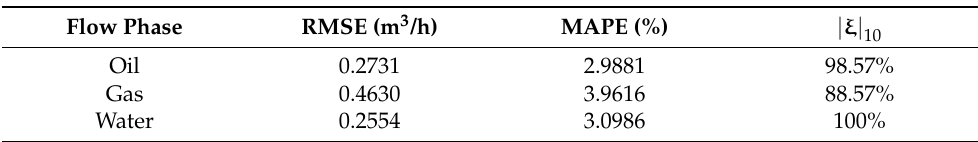
Table 10. RMSE, MAPE and | ξ | based prediction